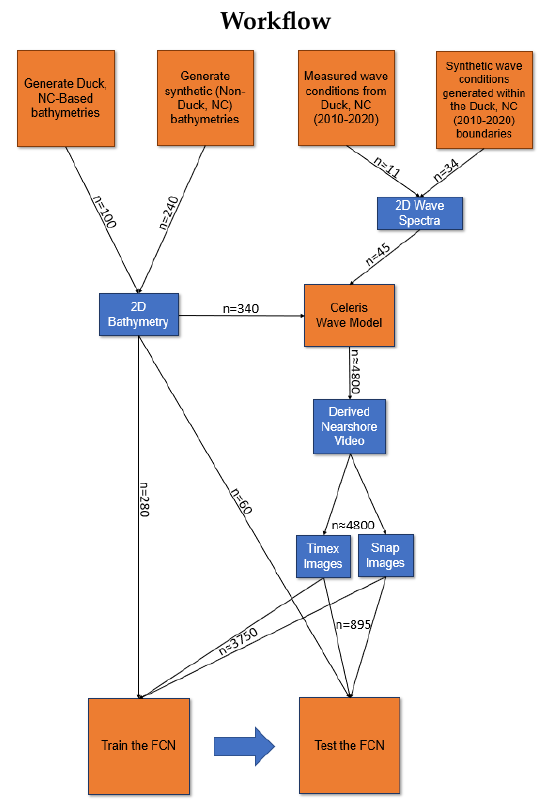
Figure 1. Workflow for the project from collecting parameters for synthetic data generation, to training and testing the fully convolutional neural network